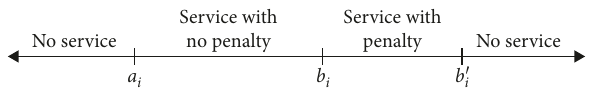
Figure 1: Service time interval in